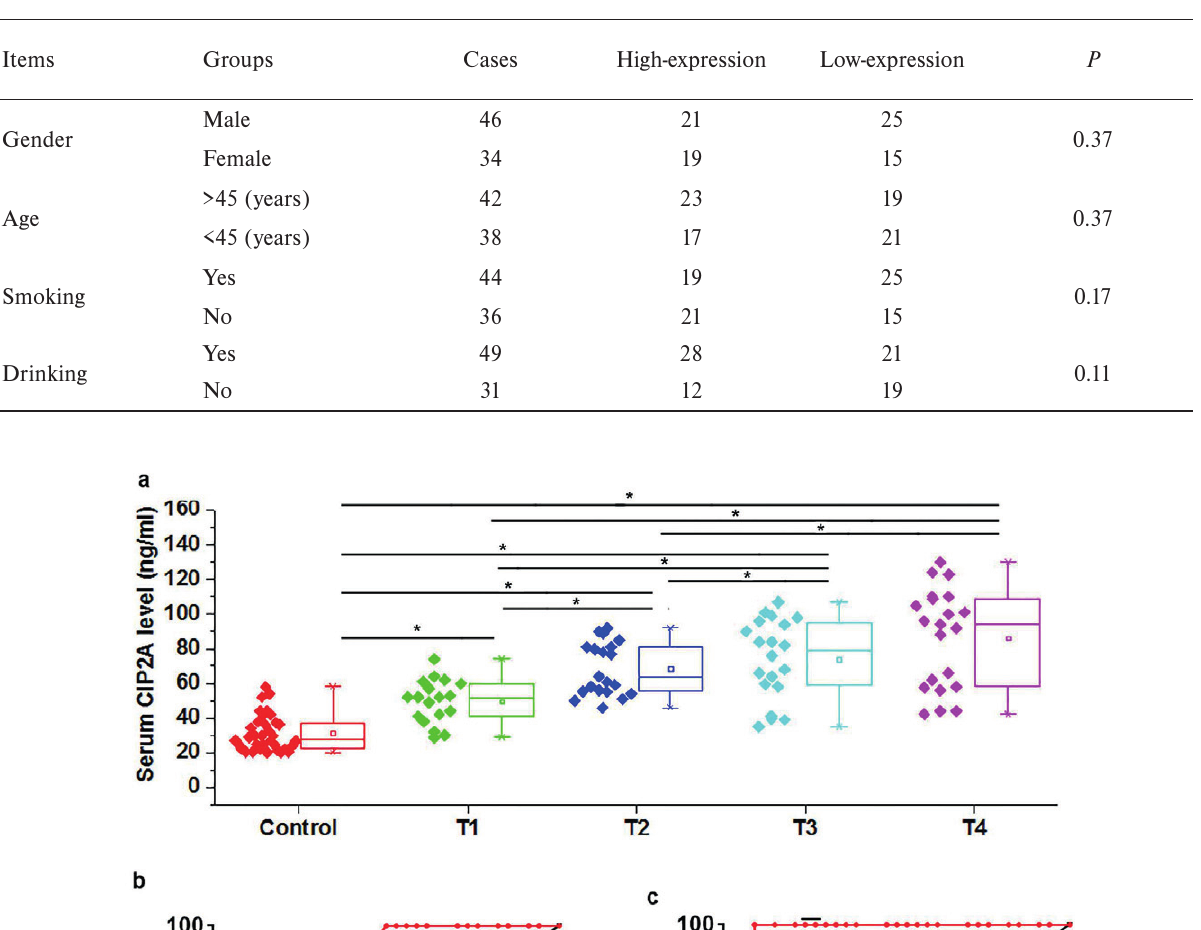
Table 1. Correlations between basic information and serum levels of CIP2A protein.